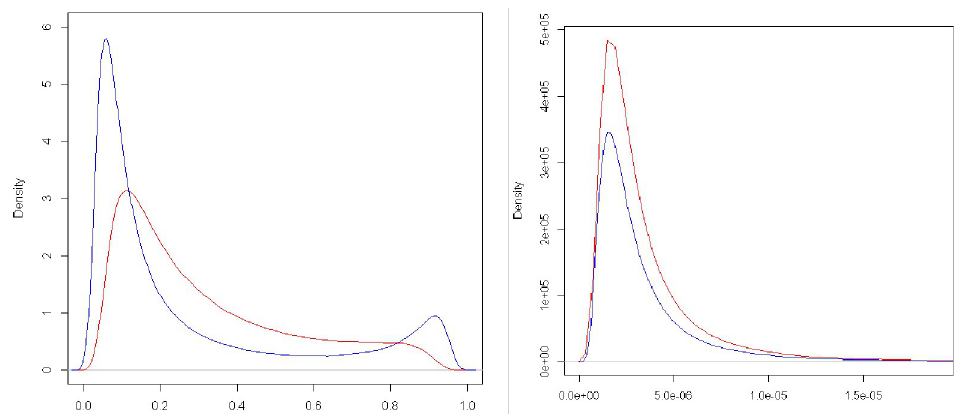
Fig 1. Posterior density for the complete model proposed by multi-traits multi-environment (left: flowering period and right: grain yield). The red line represents the posterior density for environment 1, while the blue line represents the posterior density for environment 2.